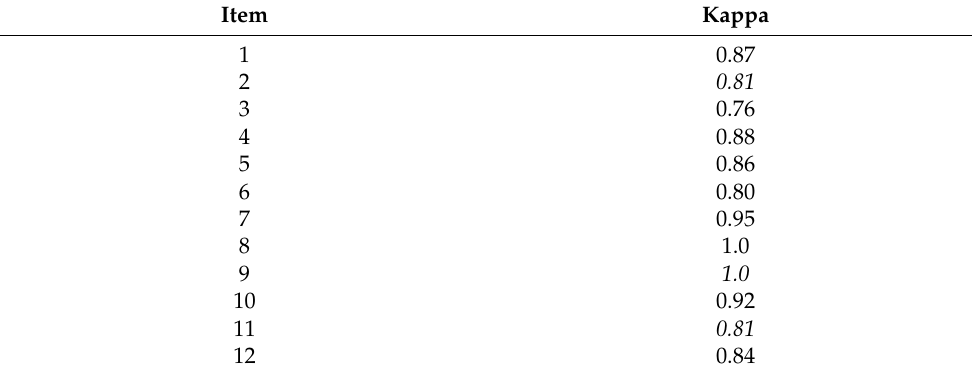
Table 3. Child test and retest results of the Portuguese version of